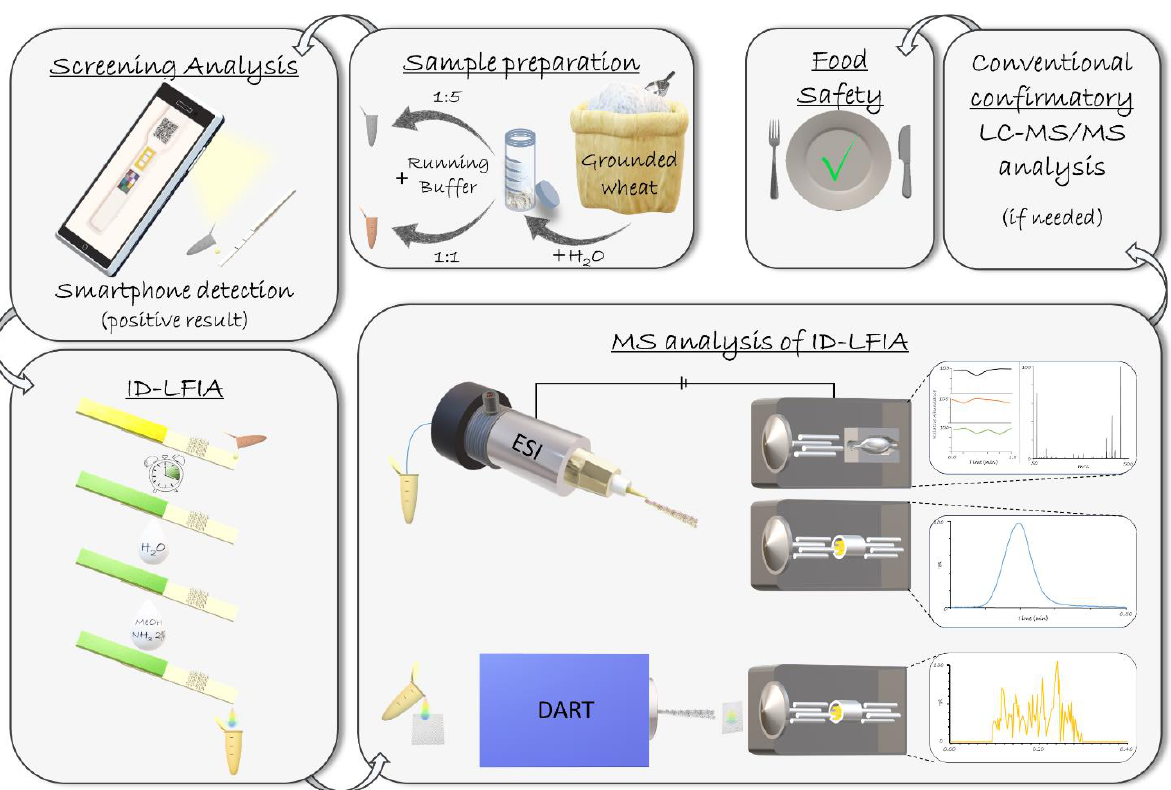
Figure 1. The general concept of the ID-LFIA DART (this work) and ESI [17] methods. DON is extracted from grounded wheat, and the extract is diluted with the running buffer on a 1:5 ratio. If the screening result is positive, the same sample extract is diluted with the running buffer on a 1:1 to develop the ID-LFIA. The ID-LFIA can then be further processed in the lab by washing and dissociating the bound DON and conjugates from the mAb. The final step is the rapid direct analysis by the newly developed and validated semi-quantitative DART-QqQ-MS/MS and the previously developed ESI-QqQ-MS/MS or ESI-Q-Orbitrap-MS. In case further information is needed, e.g., absolute quantitation over a different range or multitoxin analysis, conventional time-consuming LC-MS/MS analysis may be considered a follow-up.